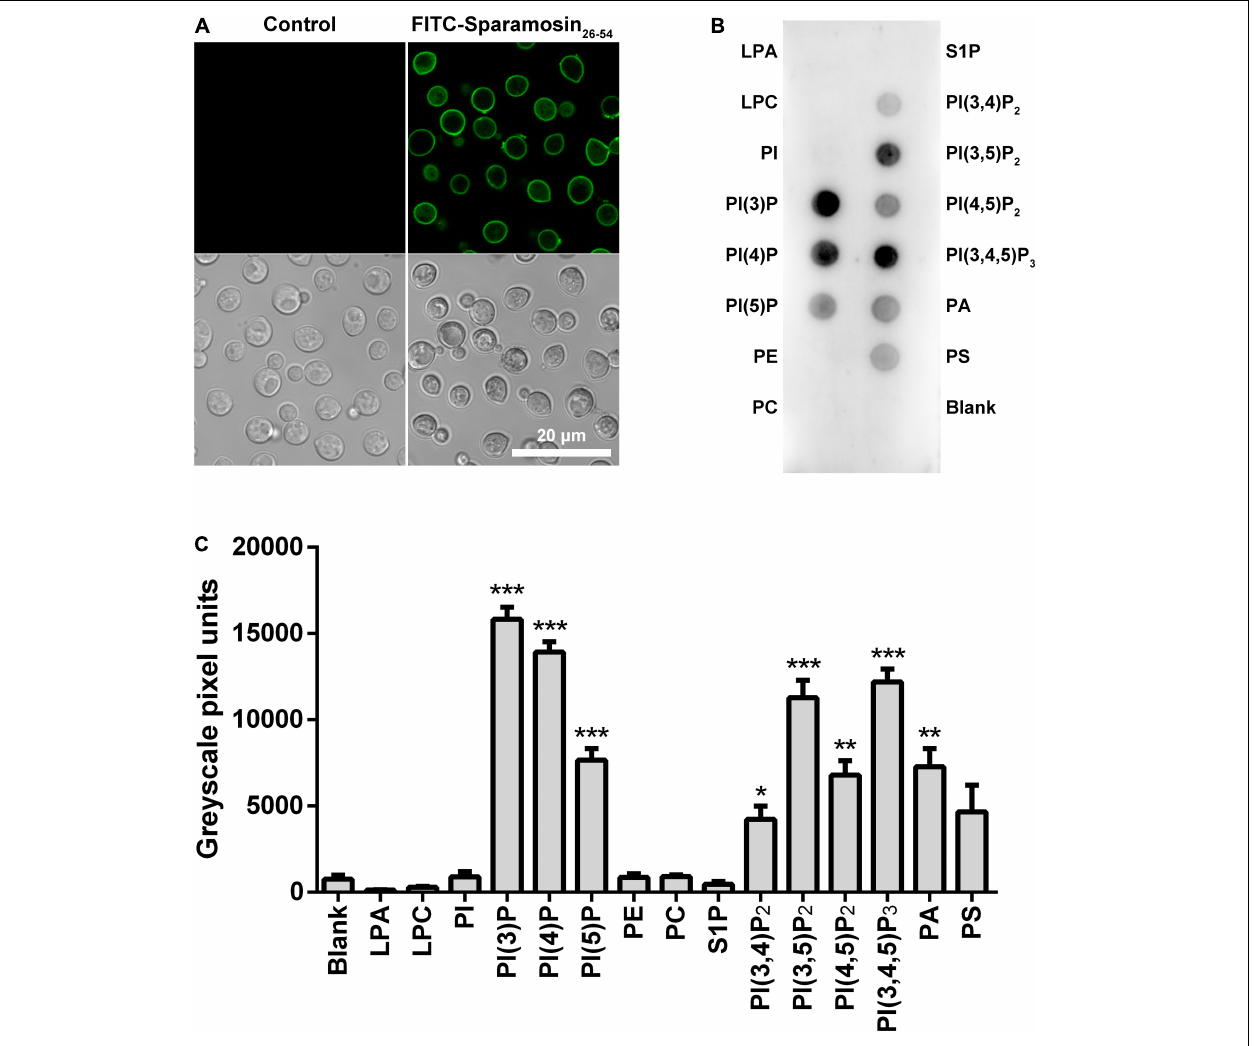
FIGURE 4 | Localization of Sparamosin 26 − 54 in C. neoformans . (A) The fungal cells were incubated with FITC-labeled Sparamosin 26 − 54 , and images were acquired using a confocal laser scanning microscopy. (B) Detection of Sparamosin 26 − 54 binding to cellular lipids by protein-phospholipid interaction assay. (C) The densitometry analysis of PIP Strips TM probed with Sparamosin 26 − 54 by Image J software. Data represent mean ± standard error of mean from three independent biological replicates. Significant difference between blank group and cellular lipids group was indicated by asterisks as * p < 0.05; ** p < 0.01; *** p < 0.001. LPA, lysophosphatidic acid; LPC, lysophosphocholine; PI, phosphatidylinositol; PI(3)P, phosphatidylinositol (3)-phosphate; PI(4)P, phosphatidylinositol (4)-phosphate; PI(5)P, phosphatidylinositol (5)-phosphate; PE, phosphatidylethanolamine; PC, phosphatidylcholine; S1P, sphingosine 1-phosphate; PI(3,4)P 2 ,